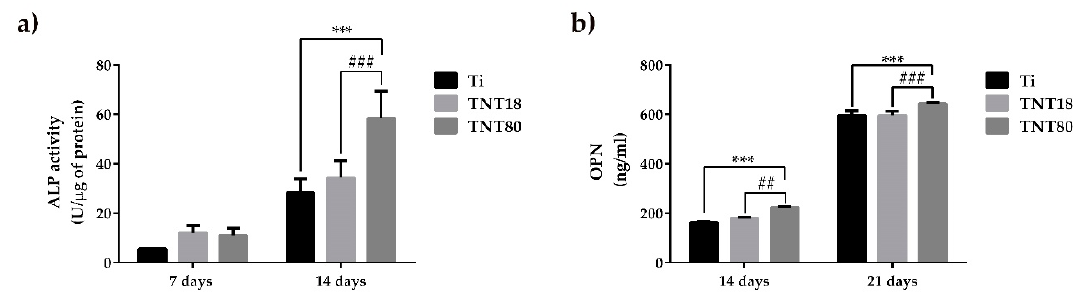
Figure 6. Evaluation of alkaline phosphatase (ALP) and osteopontin (OPN) expression. ( a ) The expression level of intracellular ALP activity of osteoblasts grown on Ti, TNT18 and TNT80 surface at 7 and 14 days in the presence of osteogenic differentiation media (n = 3, mean ± SD, *** p < 0.001 compared with Ti; ### p < 0.001 compared with TNT18); ( b ) The expression level of osteopontin released into the culture medium by osteoblasts cultivated on the tested surfaces for 14 and 21 days in the presence of osteogenic medium (n = 3, mean ± SD, *** p < 0.001 compared with Ti; ## p < 0.01, ### p < 0.001 compared with TNT18).